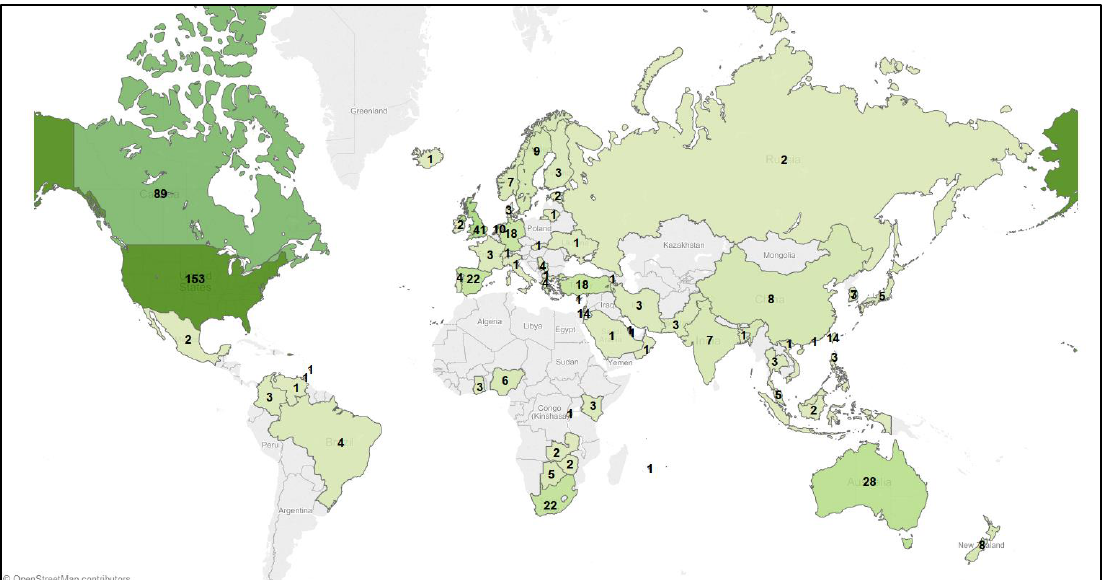
Figure 5. Countries of origin of first